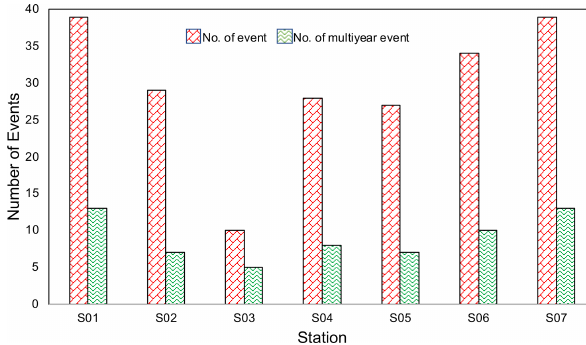
Figure 7. Number of drought events.